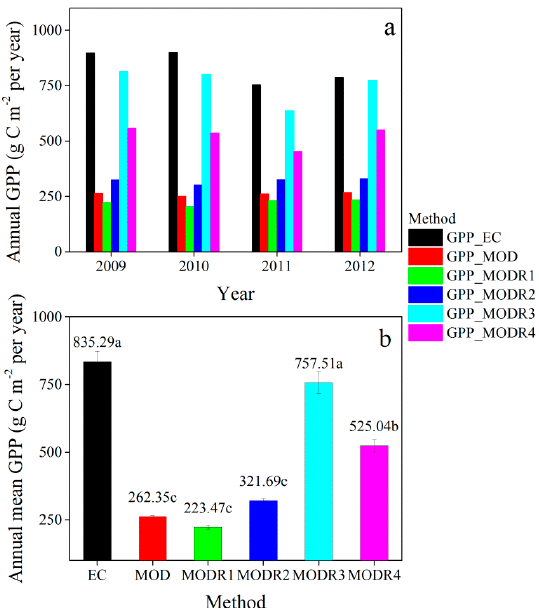
Figure 5. Inter-annual GPP variations from the field GPP measurement (GPP_EC) and five MODIS-based GPP estimations (GPP_MOD, GPP_MODR1, GPP_MODR2, GPP_MODR3, and GPP_MODR4) ( a ) and the difference among different estimation methods ( b ). The error bars in b are the standard deviation of the mean annual GPP estimation from 2009 to 2012. The bar with the same lowercase indicates no significant difference among diverse GPP estimation methods ( p > 0.05).